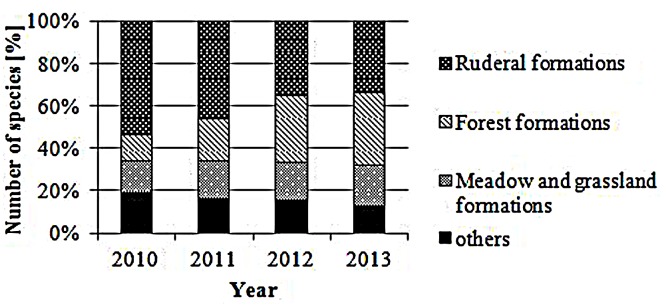
Plant formations. Proportion [%] of ruderal, forest, meadow and grassland and other plant species according to Korneck and Sukopp (1988).